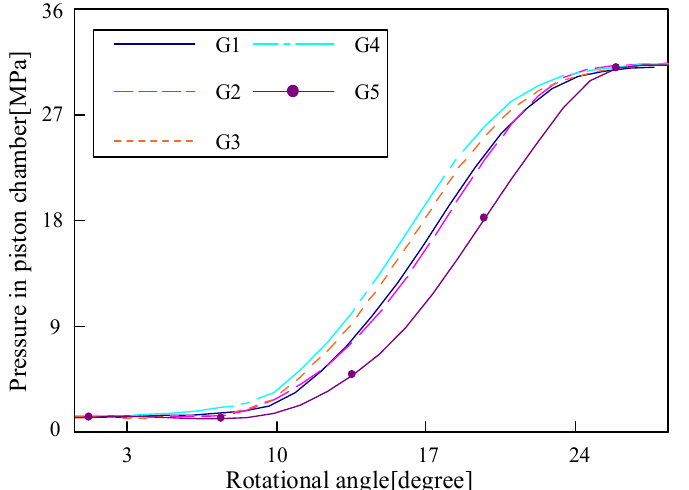
Figure 13. Pressure in the piston chamber with different slot geometries at the beginning of the discharge phase .